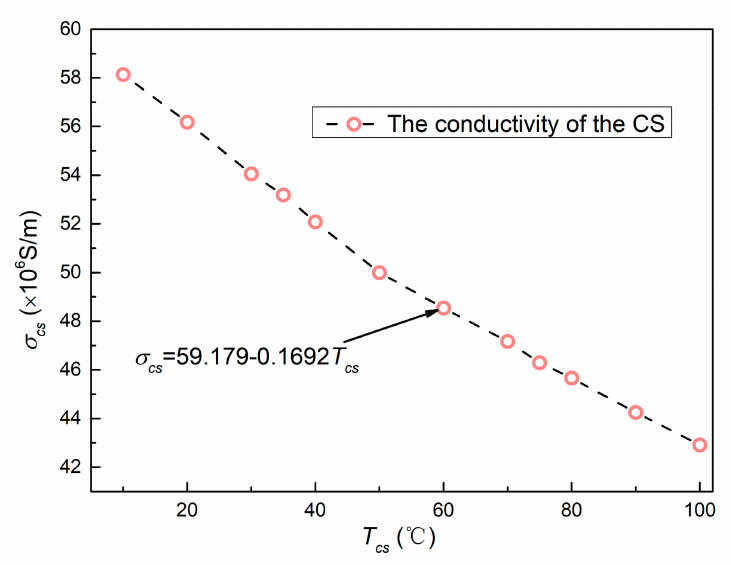
Figure 13. The relationship between the conductivity of the CS and di ff erent temperature.